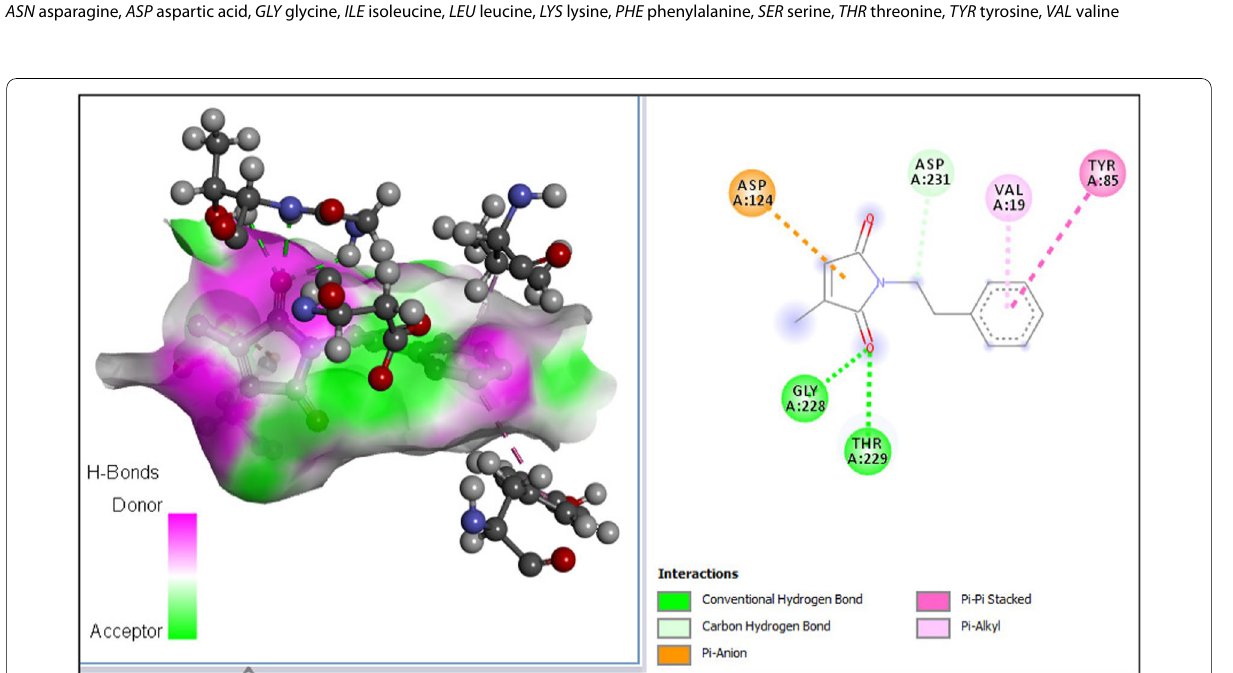
Fig. 5 2D and 3D view of the interaction between compound 14 and PdxK